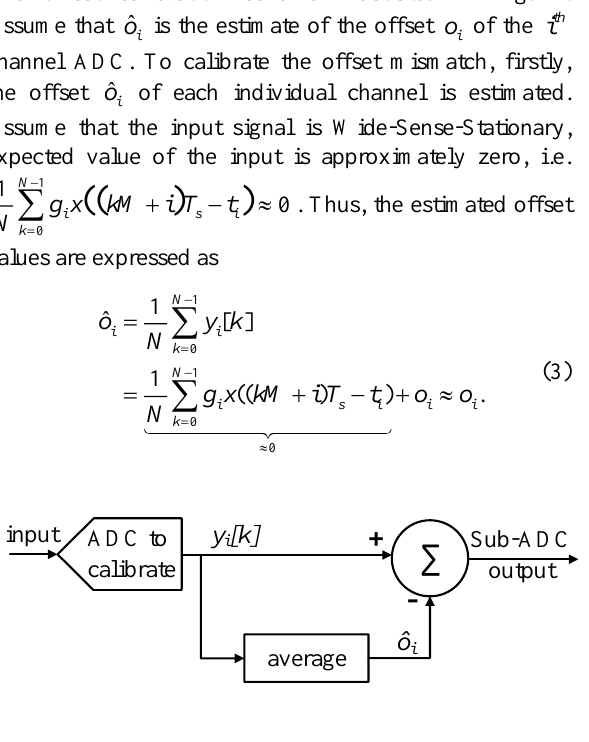
Figure 2. Offset mismatch calibration for each sub-ADC. Firstly, the offset error can be calibrated by averaging the output of each sub-ADC over N samples as in (3) end then subtracting the average value from the ADC output as